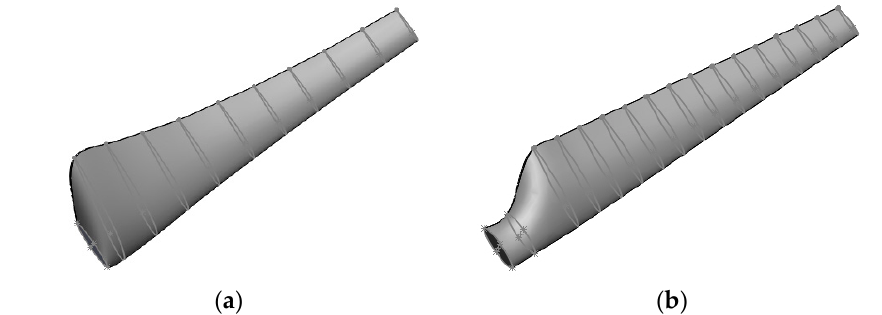
Figure 9. Designed blade geometries for CFD validation: ( a ) OPT blade from [10]; ( b ) Tidal current turbine blade from [14].